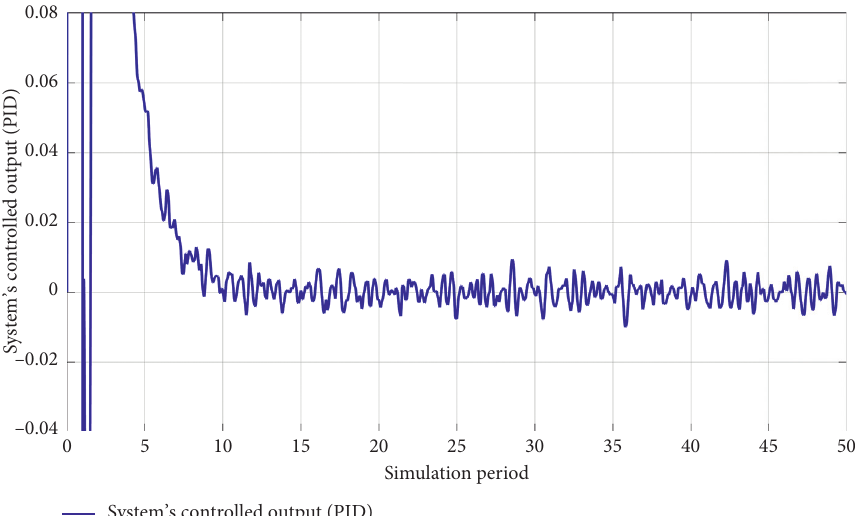
Figure 10: Noise cancellation utilizing PID